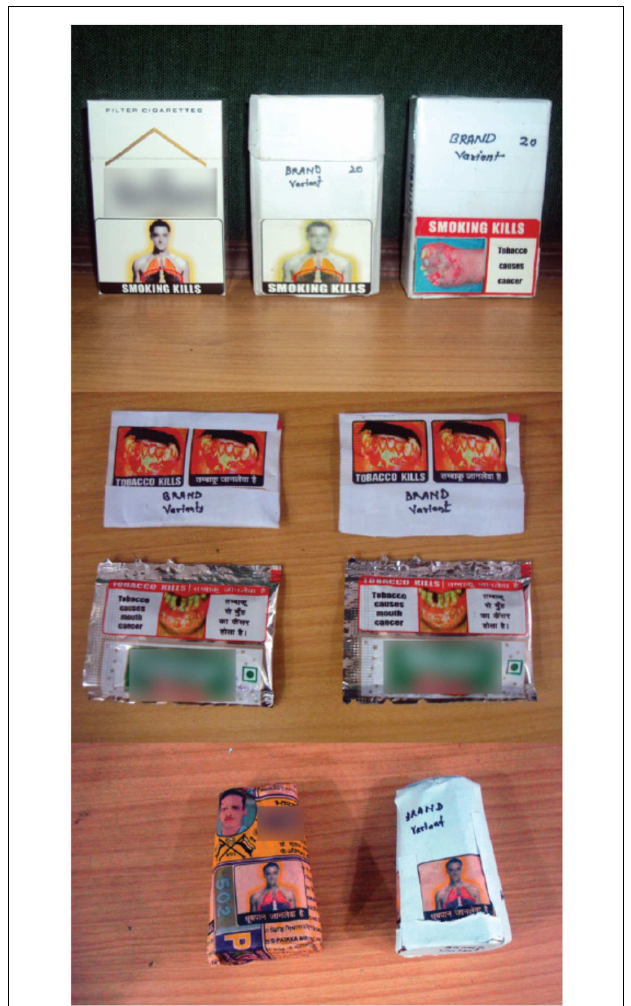
FIGURE 1 | Dummy plain packs of tobacco products